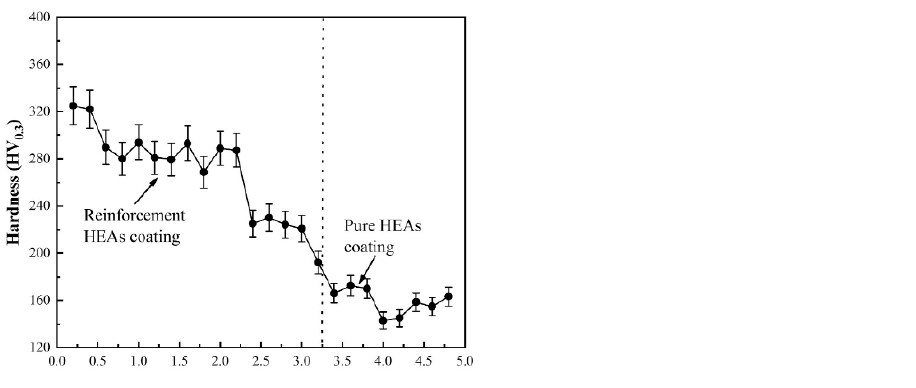
Figure 15. Microhardness distribution of reinforced HEA coating. Reprinted with permission from ref. [106]. Copyright 2022 Elsevier.